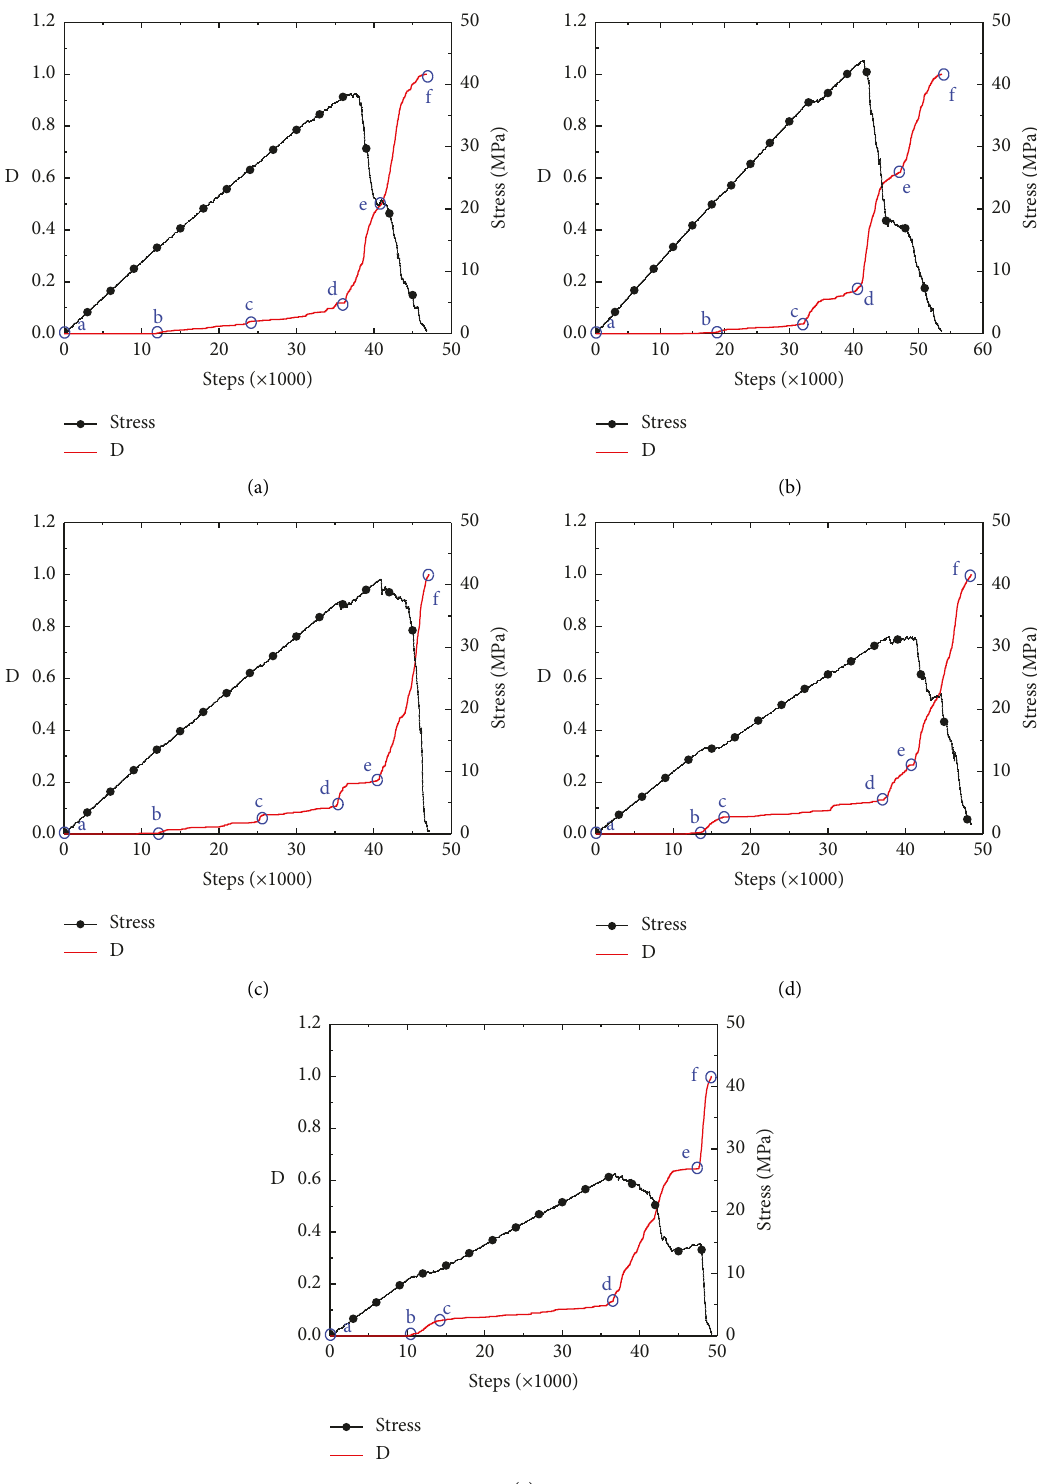
Figure 10: Damage evolution characteristics of rocks with different joint cross-angles. (a) β � 30 ° . (b) β � 60 ° . (c) β � 90 ° . (d) β � 120 ° . (e) β � 150 °